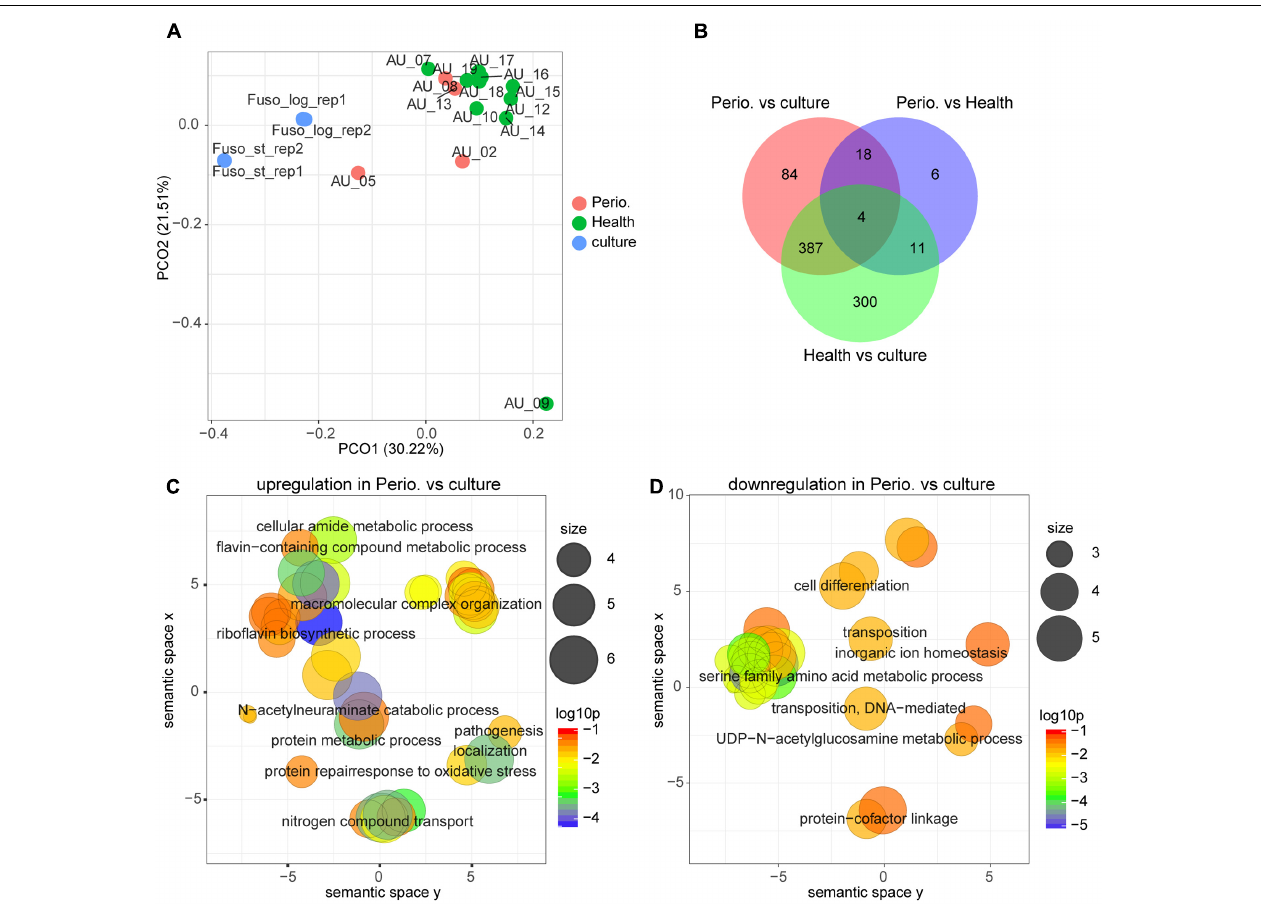
FIGURE 3 | Comparison of the transcriptional profiles between periodontitis, health and laboratory culture for F. nucleatum . (A) PCoA of transcriptional profiles of Fusobacterium nucleatum in four periodontal pocket samples from patients with chronic periodontitis, 10 periodontal pocket samples from healthy individuals and four laboratory cultures at log or stationary phase. (B) Venn diagram showing the number of differentially expressed genes in each comparison. (C,D) GO terms up-regulated (C) and down-regulated (D) in periodontitis in comparison to laboratory culture. All GO terms with enrichment P -value ≤ 0.05 were summarized and visualized by REVIGO, and the size of the bubble indicates the number of merged